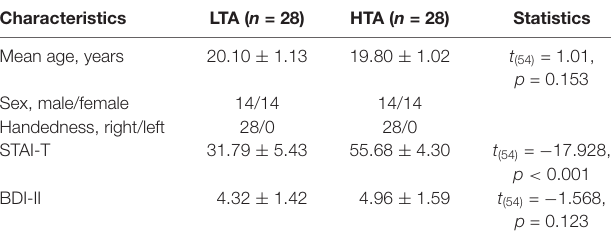
TABLE 1 | Demographic data of participants with high trait anxiety (HTA) and low trait anxiety